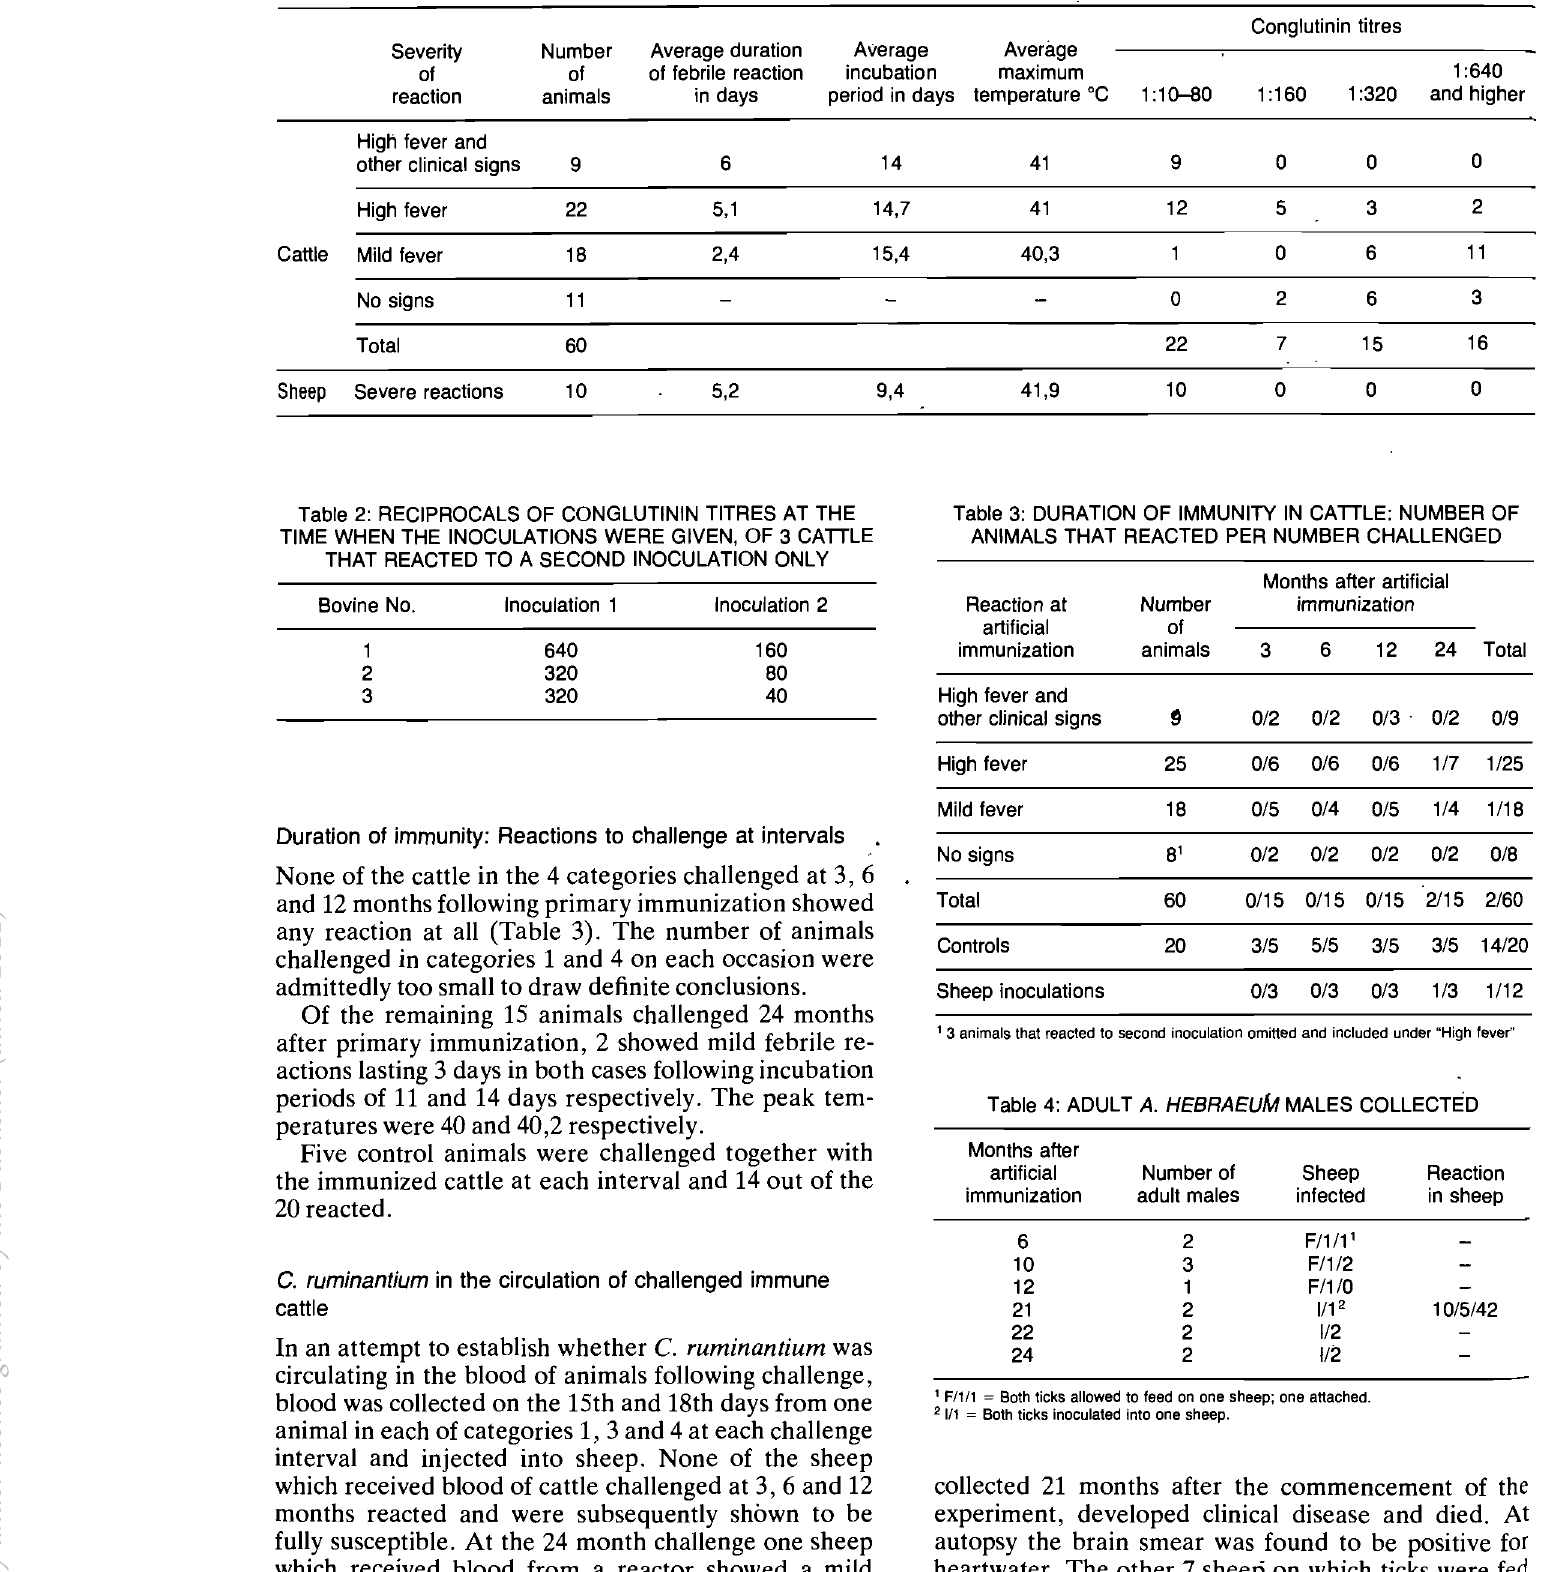
Conglutinin titres